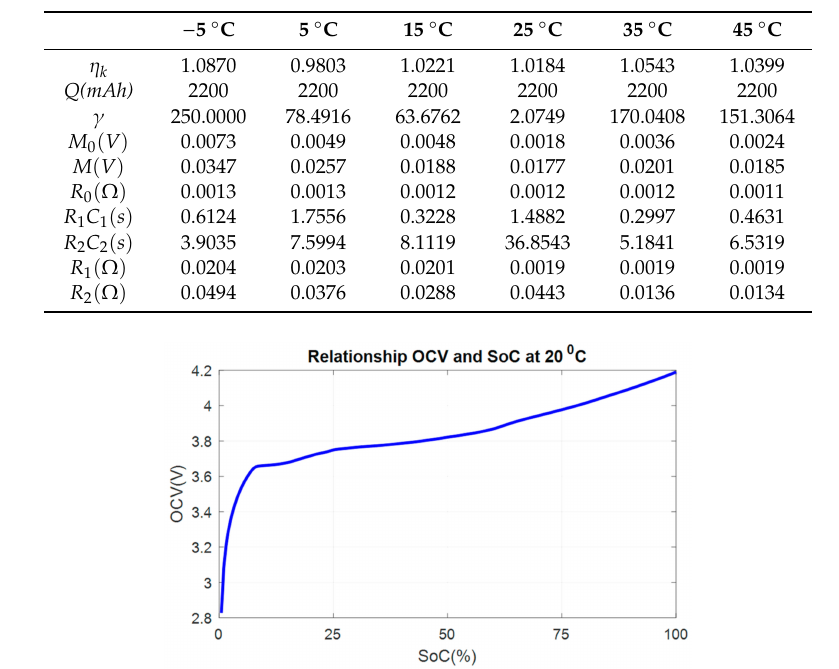
Table 1. The second order dynamic parameters of the cell with respect to the temperature.